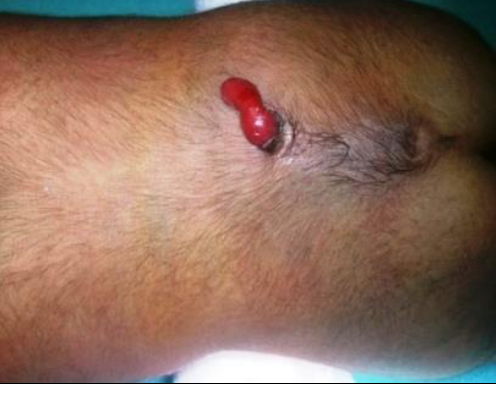
Figure 1: Reddish tubular structure at the lower back